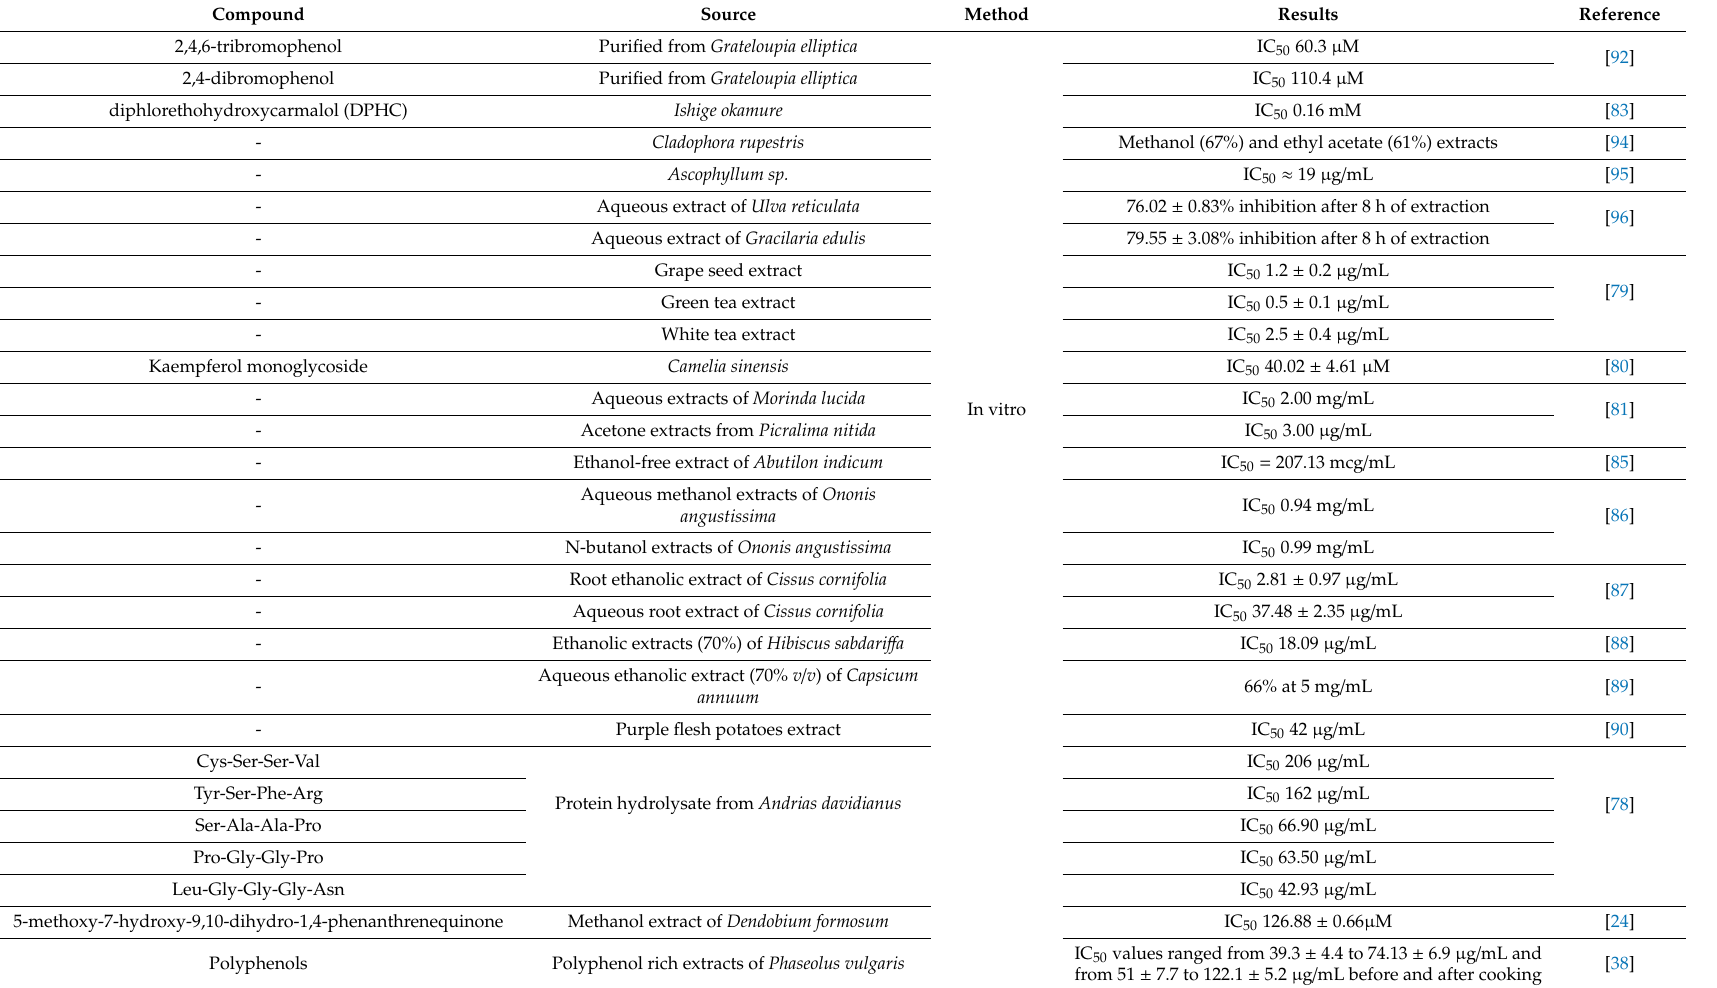
Table 5. Natural alpha-glucosidase